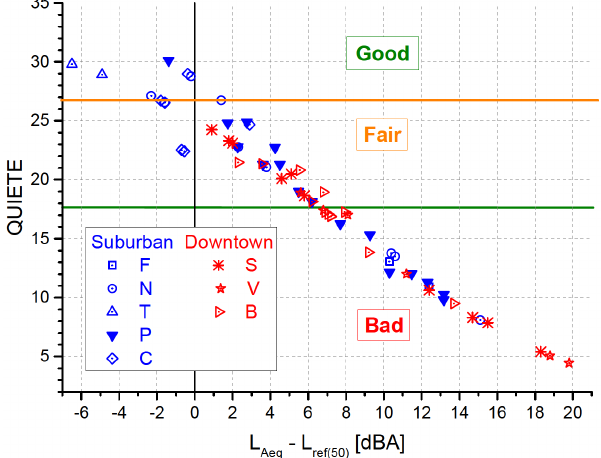
Figure 9: QUIETE values obtained for all the 8 parks.